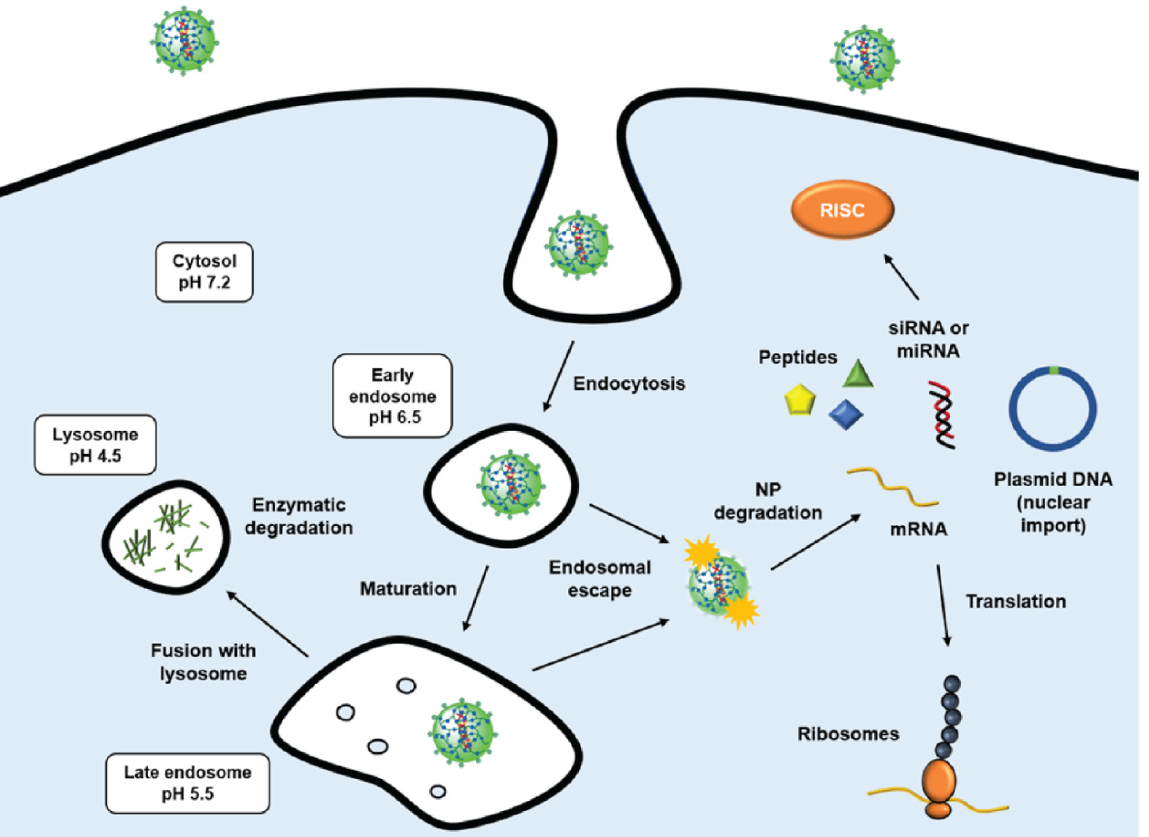
Figure 3. Intracellular trafficking of cationic polymeric nanoparticles. Cell attachment is based on electrostatic interaction between positive charges of nanoparticles and negatively charged groups at the cell surface (e.g., glycosaminoglycans or sialic acid-bearing glycans), followed by the endocytosis of the nanocarriers. Once these NPs are internalized into endosomes, they may escape to the cytosol by the so-called “proton-sponge effect” [123]. According to this model, under the acidic conditions found in endosomes (pH range 6.5 to 5.5), these cationic polymers display buffer abilities by absorbing free protons in the endosome lumen, which in turn leads to an increase in the internal osmotic pressure. High osmotic pressure causes water to shift from the cytosol into the endosome, eventually leading to the burst and release of the entrapped materials. Finally in the cytosol, the nanoparticle is degraded through a biodegradable polymer–drug linkage, which enables controlled release of cargo. If endosomal escape does not occur, the late endosome fuses with the lysosome (pH ≈ 4.5), and the NP is degraded by hydrolytic enzymes. Figure adapted from Figure 1 in reference [124].